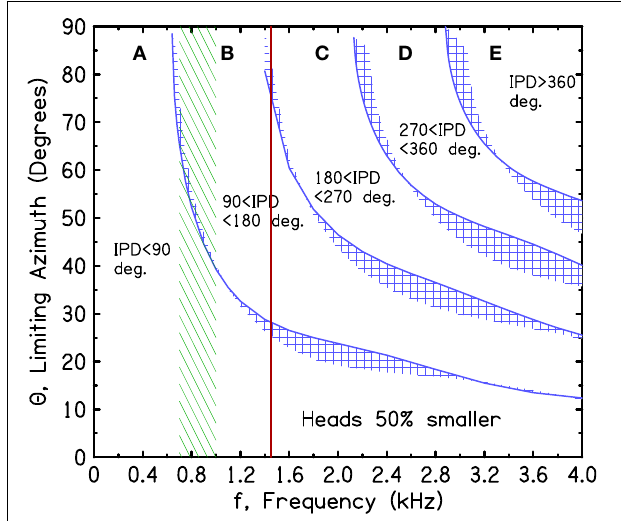
FIGURE 8 | Same as Figure 7 for a head diameter that is half as large as present-day human